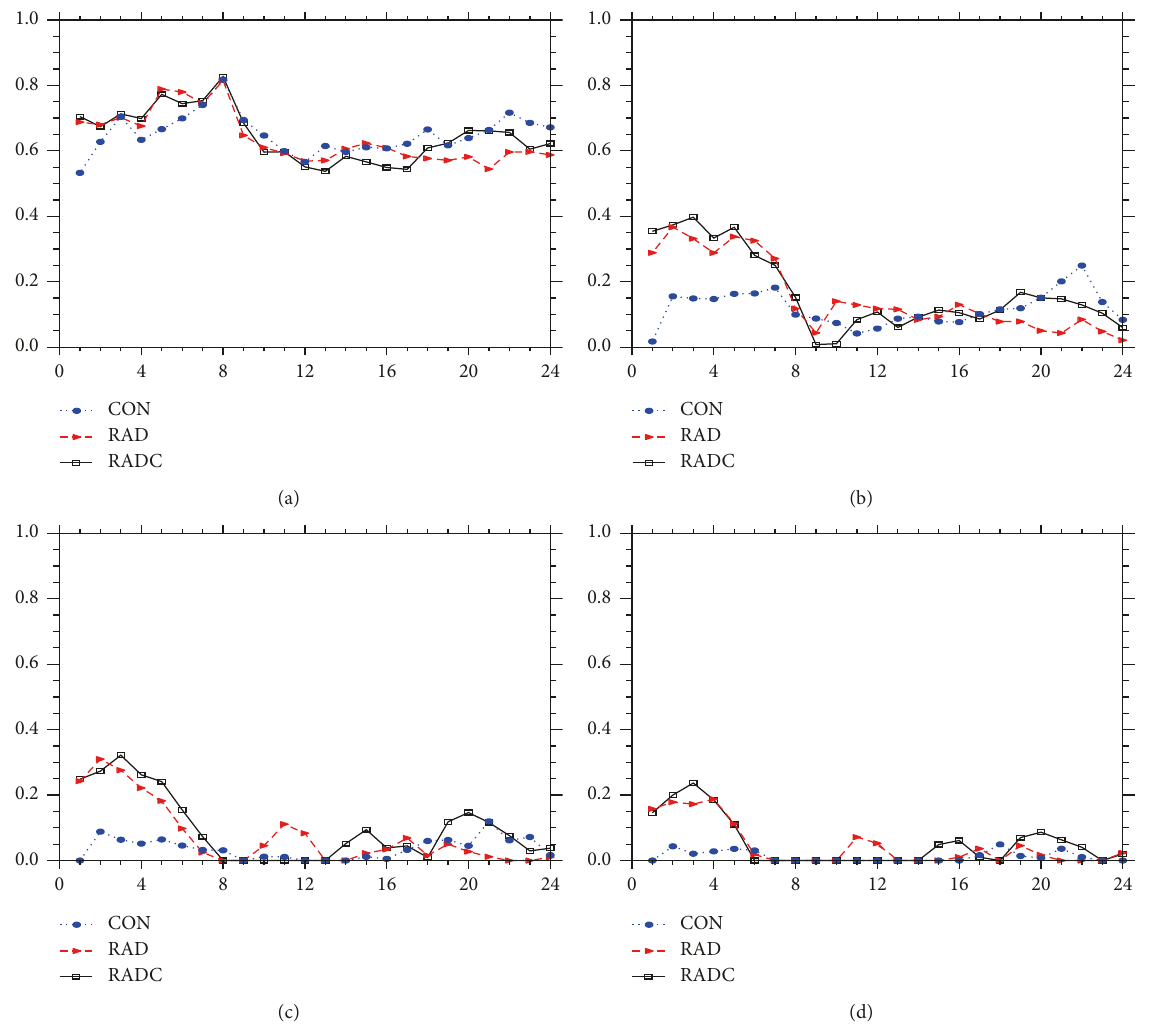
Figure 10: The 1h TSs of CON, RAD, and RADC for various thresholds: (a) horizontal axis is forecast hours from 0000 UTC 4 July to 0000 UTC 5 July 2014.